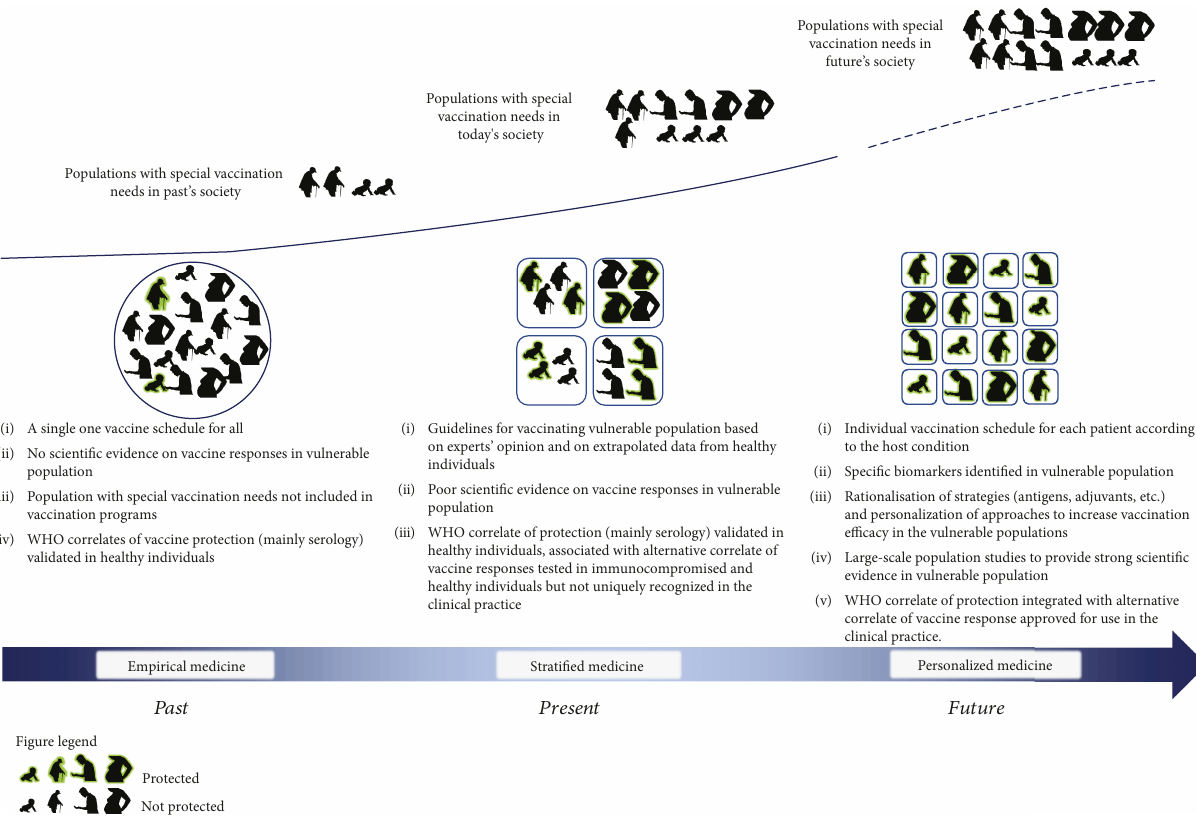
Figure 2: The fi gure shows changes in populations ’ composition with special vaccination needs over time. Traditionally, only elderly people and infants were considered vulnerable. During this time period, little scienti fi c evidence regarding vaccine responses of di ff erent populations was available, and a single vaccination schedule was proposed for all (empirical medicine). Currently, an increasing number of people with special vaccination needs, such as immunocompromised patients and pregnant women, are considered in speci fi c vaccine programs based on expert opinion and on extrapolated data from healthy individuals (strati fi ed medicine). In the near future, the increased number and life expectancy of groups with special vaccination needs will lead to large-scale population studies. This approach will provide robust scienti fi c evidence and new correlates of protection and safety. As a result, rationalisation of vaccine strategies (antigens, adjuvants, etc.) and personalization of approaches will increase vaccination e ffi cacy and safety in these populations within a framework of personalized